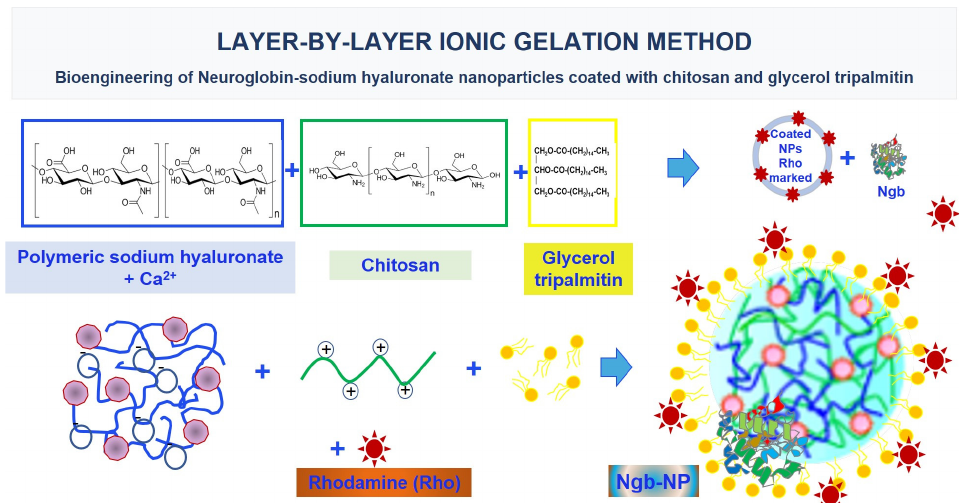
Figure 4. Layer-by-layer ionic gelation method: bioengineering of Ngb-sodium hyaluronate NPs coated with chitosan and glycerol tripalmitin. NPs have been constructed following layer-by-layer ionic gelation methods. These methods depend on ionic interactions between anionic chains of so- dium hyaluronate and cationic charged polyions (e.g., calcium cations) as a cross linker. Then, these NPs can be coated with materials like chitosan or lipids, enhancing their specificity as carriers and providing better targeting. Finally, rat-recombinant Ngb has been attached to NPs (Ngb-NPs). These bioengineering Ngb-NPs are toxicity free and adequate in size and surface charge to deliver Ngb to the stroke damaged neurons.